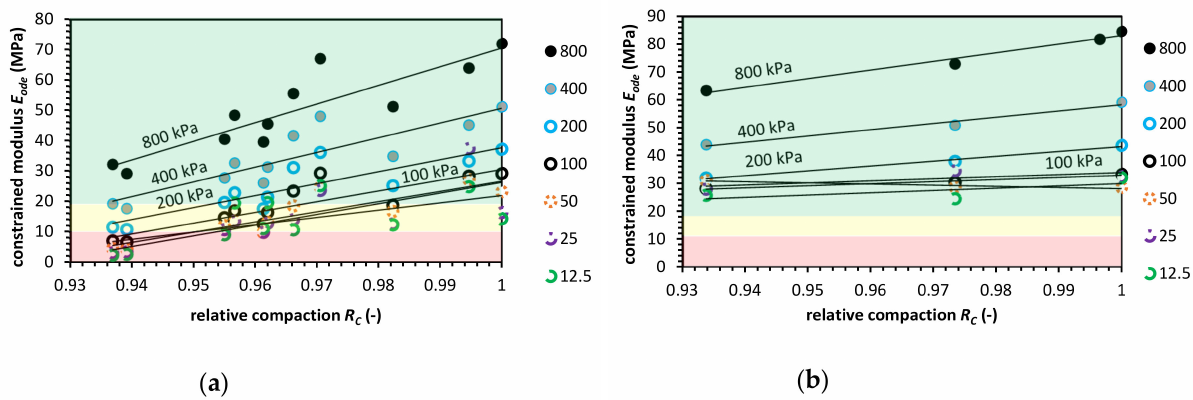
Figure 3. Constrained modulus value versus relative compaction value for natural aggregate (NA) for ( a ) the Proctor compaction and ( b ) the Vibro compaction method. Colored areas mean required constrained modulus value, colors indication: green-zone of fulfilled E ode modulus requirement; yellow-moderate zone, where the constrained modulus is in the range of requirements; red-zone in which the E ode do not meet pipe fill